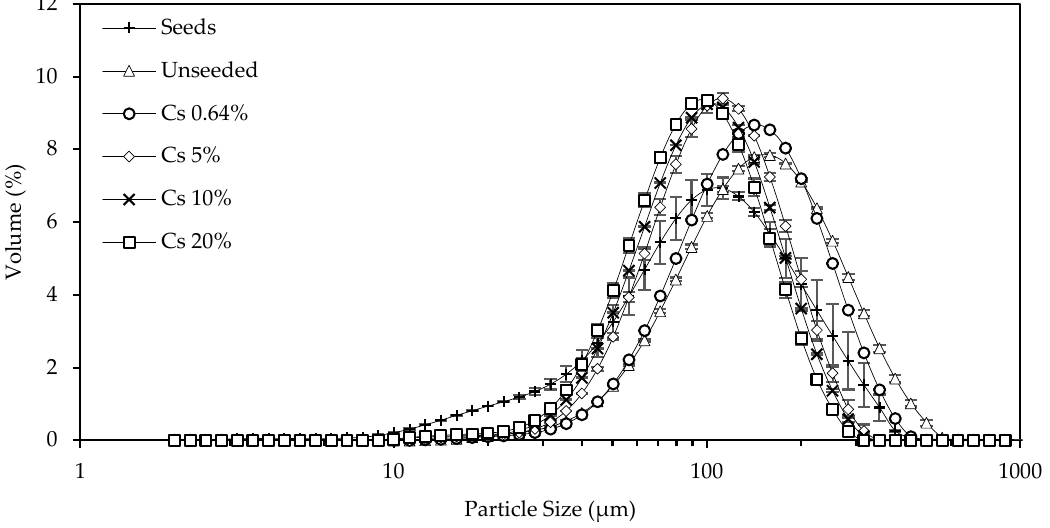
Figure 8. Effect of seed loading on the PSD of Nd 2 (SO 4 ) 3 .8H 2 O product.